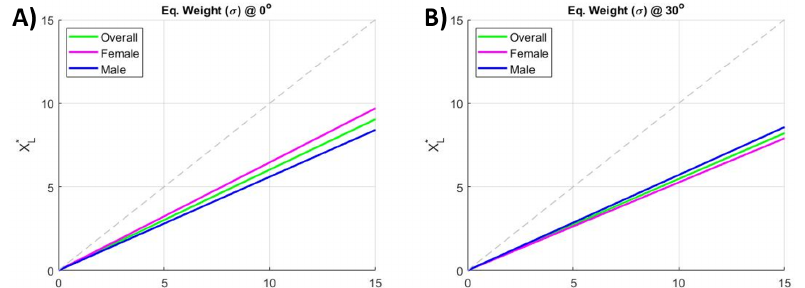
Figure 8. ( A ) EqW ( σ ) trend for the whole population and female and male populations at 0 ◦ inclination for the four load conditions. ( B ) EqW trend for the whole population and female and male populations at 30 ◦ inclination for the four load conditions. Table 7. Overall coefficient σ for different weights, trunk inclinations, and gender populations.